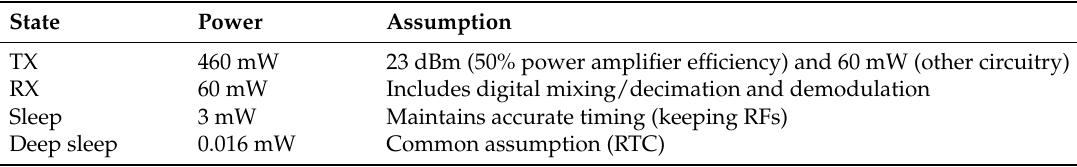
Table 5. Power Consumption According to UE